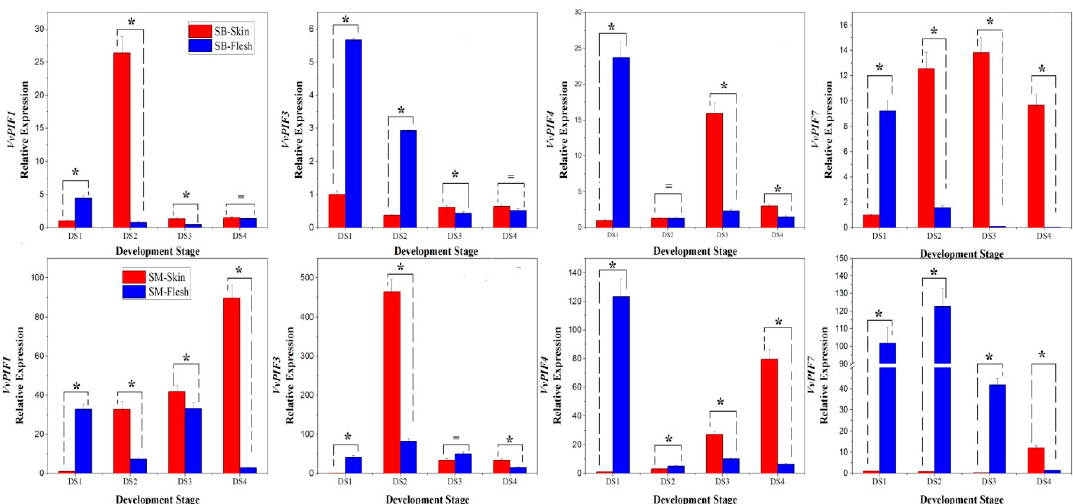
Figure 7. Relative expression levels of VvPIFs in the skin and flesh of SB (top panels) and Shine Muscat (SM; bottom panels) berries during different developmental stages (DS). Stars indicate significant differences between skin and flesh ( p < 0.05) according to Duncan’s multiple test, while the equal sign means non-specific difference. DS1, DS2, DS3, DS4 represent the early stage of fruit enlargement, pre- verasion , post- verasion and maturity respectively. The skin of SB and SM were purple-black and yellow-green, respectively. Due to the low expression values of PIFs in these organs, expression levels were calculated based on the 2 − ∆∆ Ct method with the first stage sample chosen as a reference for convenience of observation.